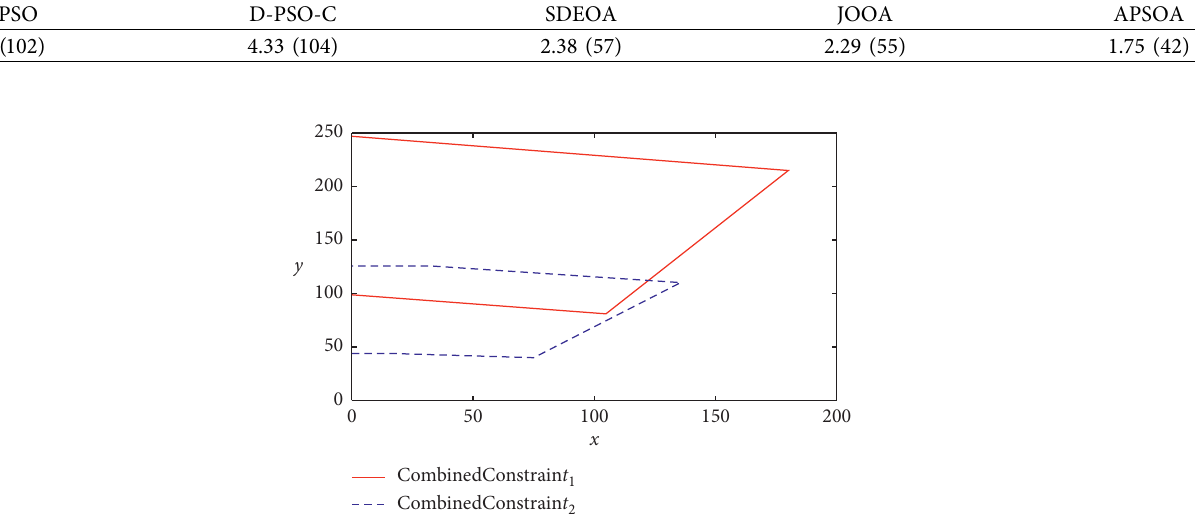
Figure 3: Two conditions for two cogeneration power-heat units. Table 10: Solutions of different optimization algorithms to the combined heat and power economic dispatch problem.